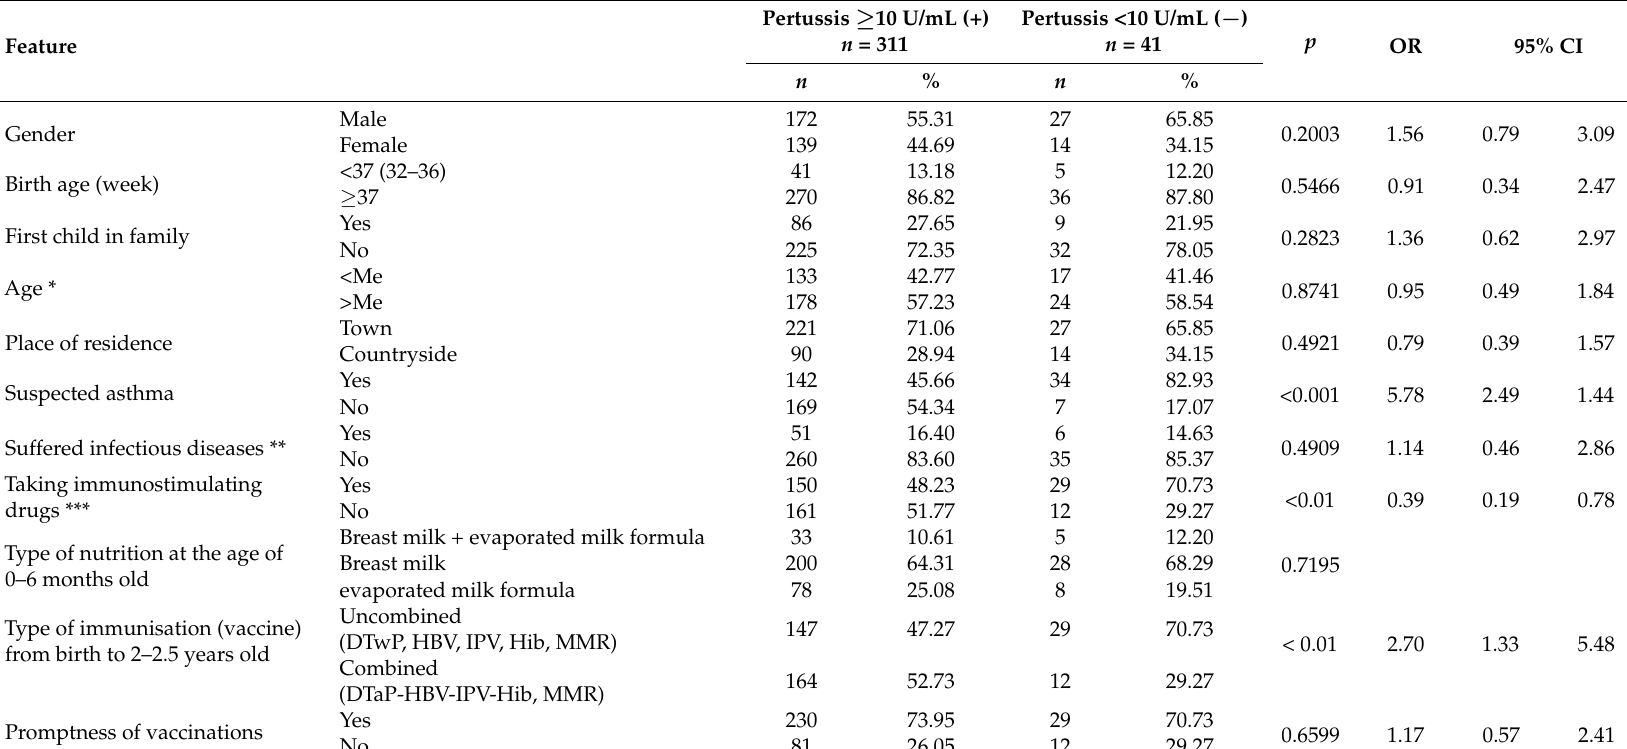
Table 2. Pertussis antibody titre and selected demographic, medical and vaccinological